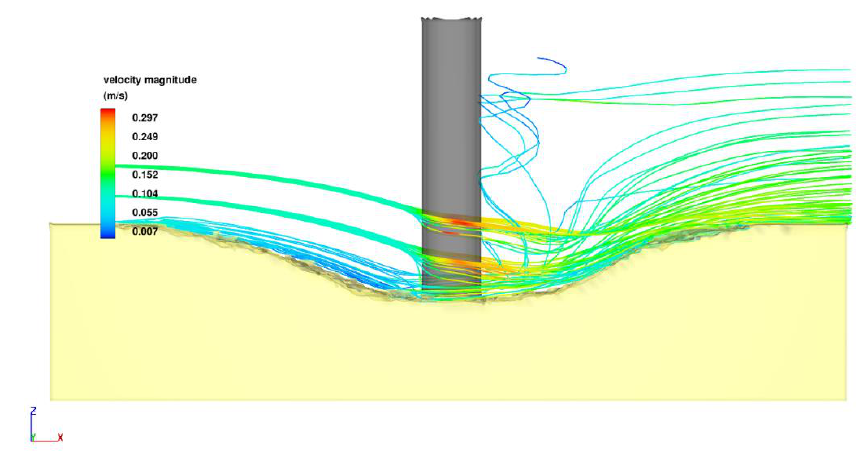
Figure 11. Streamline and scour topography of Case 1 at the end of the simulation